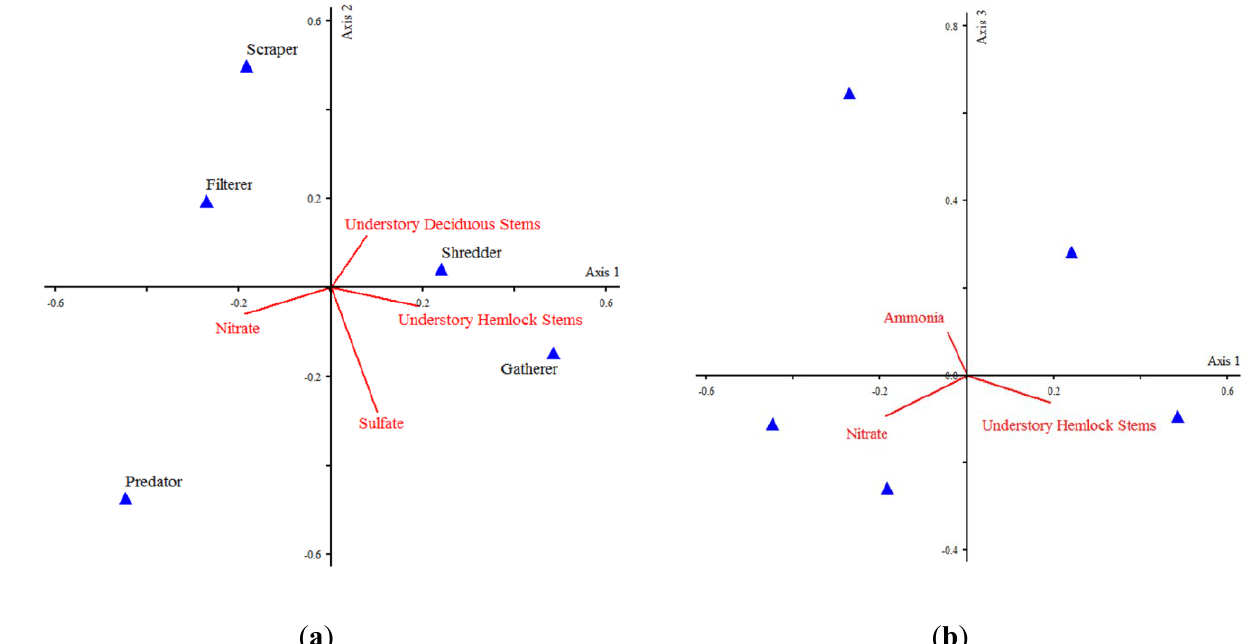
Figure 3. Canonical correspondence analysis showing ( a ) ordination axis 1 and 2; and ( b ) ordination axis 1 and 3 for benthic invertebrate functional feeding groups collected from headwater streams with riparian zones dominated by eastern hemlock and deciduous trees at the Robinson Forest site in